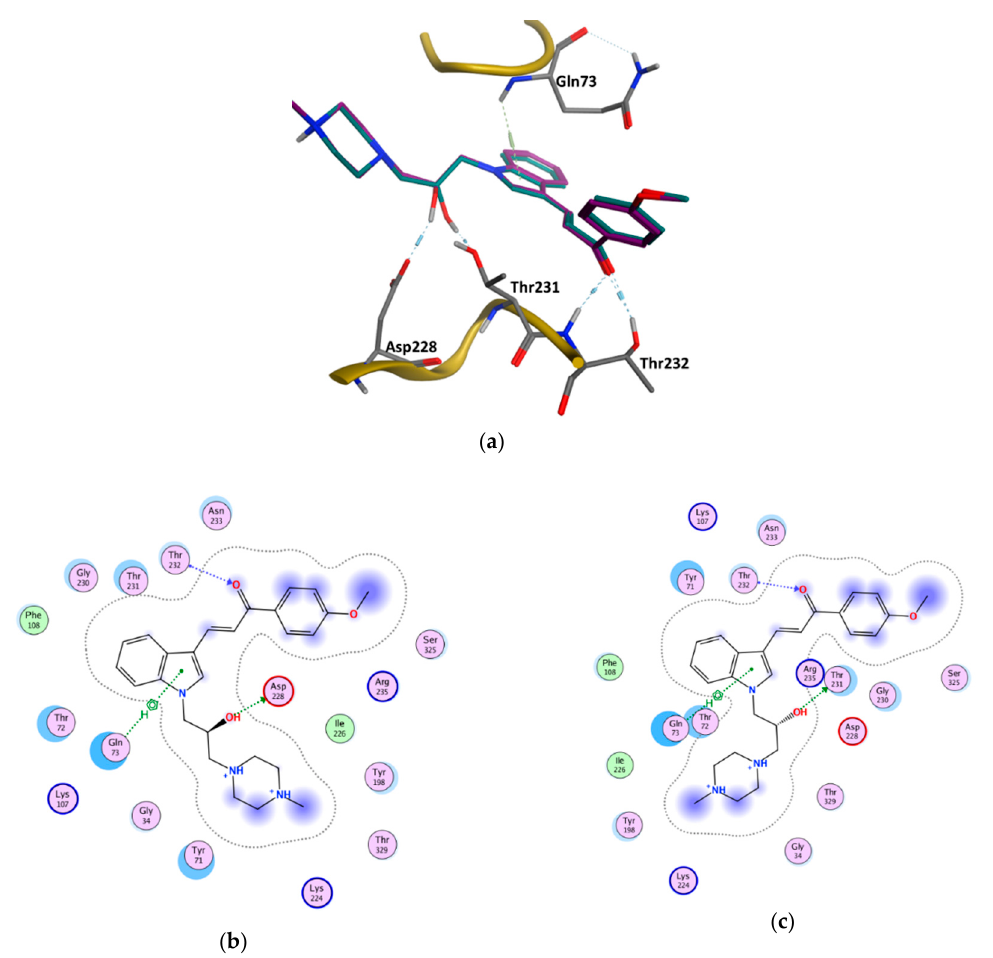
Figure 9. The binding modes of the two enantiomeric forms of compound 11 into the BACE1 active site (PDB ID: 2QP8), predicted by ChemPLP fitness function implemented in GOLD. ( a ) Superposition of the binding poses of ( S )-enantiomer (purple) and ( R )-enantiomer (blue). Highlighted amino acids are Gln73, Asp228, Thr231, and Thr232 involved in the ligand-protein interactions, the hydrogen bonding is depicted as blue dashed lines and aromatic interaction is colored in green. 2D ligand interactions diagram of ( S )-enantiomer ( b ) and ( R )-enantiomer ( c ). Green arrow represents sidechain acceptor; Blue arrow indicates backbone donor; Green dash lines with an arene symbol represents π -hydrogen interaction. The binding site residues are colored by their nature, with hydrophobic residues in green and polar residues in purple (blue and red contours indicate basic and acidic residues, respectively). The schematic pictures were generated using